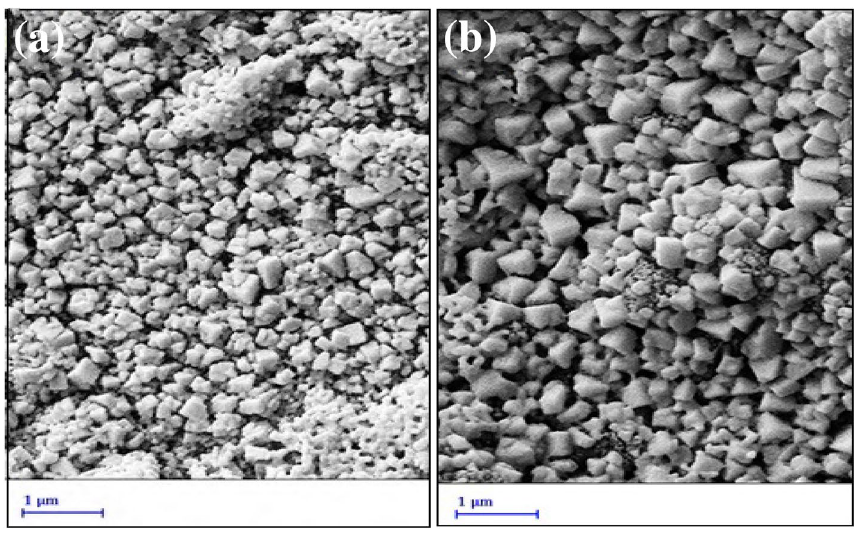
Figure 5. Top-view SEM images of the MAPbI 3 perovskite films deposited on ( a ) SnO 2 @ZnOnanocomposite and ( b ) SnO 2 @ZnO.PANI 4%